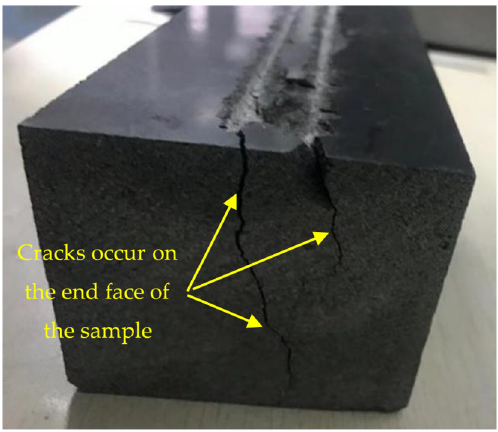
Figure 9. The end face of the sample cracked after two cutting marks.